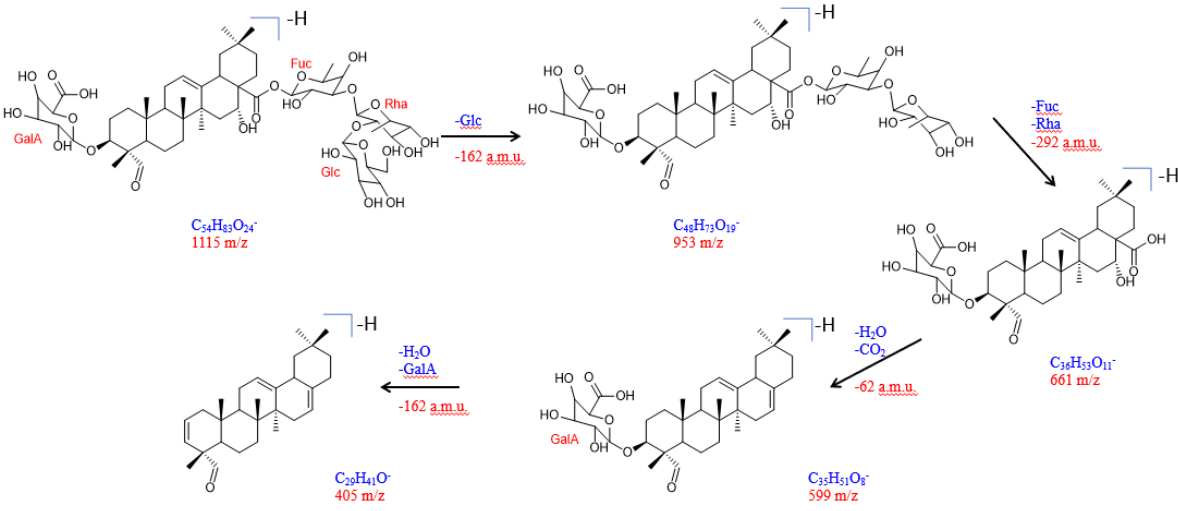
Figure 2. Proposed fragmentation pathway for silviridoside (compound 1 ) in ESI-MS/MS negative mode.